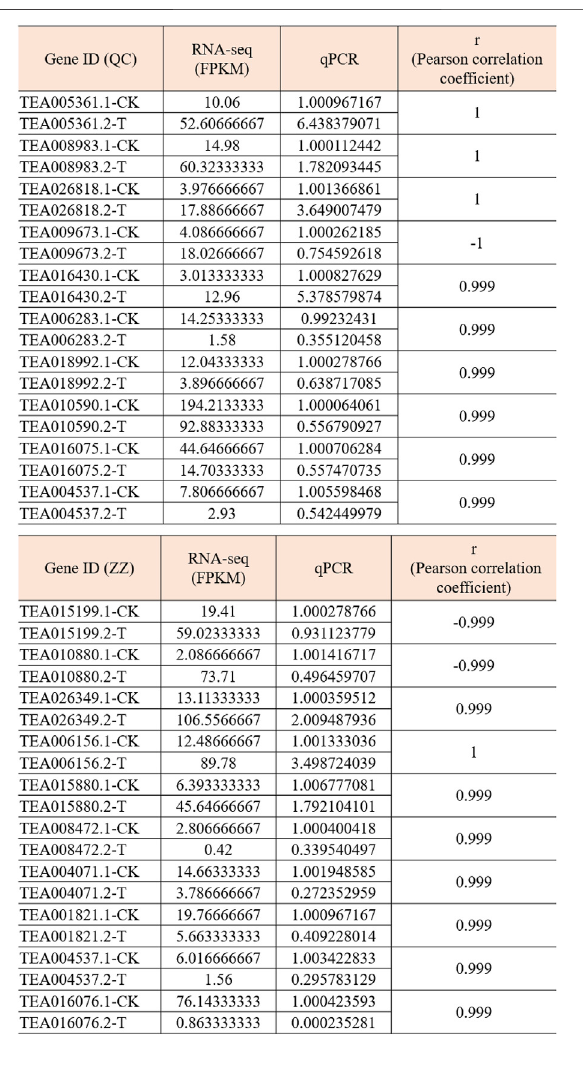
FIGURE 12 | Correlation analysis between RNA-seq and qPCR. Pearson coef fi cient is used for correlation analysis, and r represents the correlation coef fi